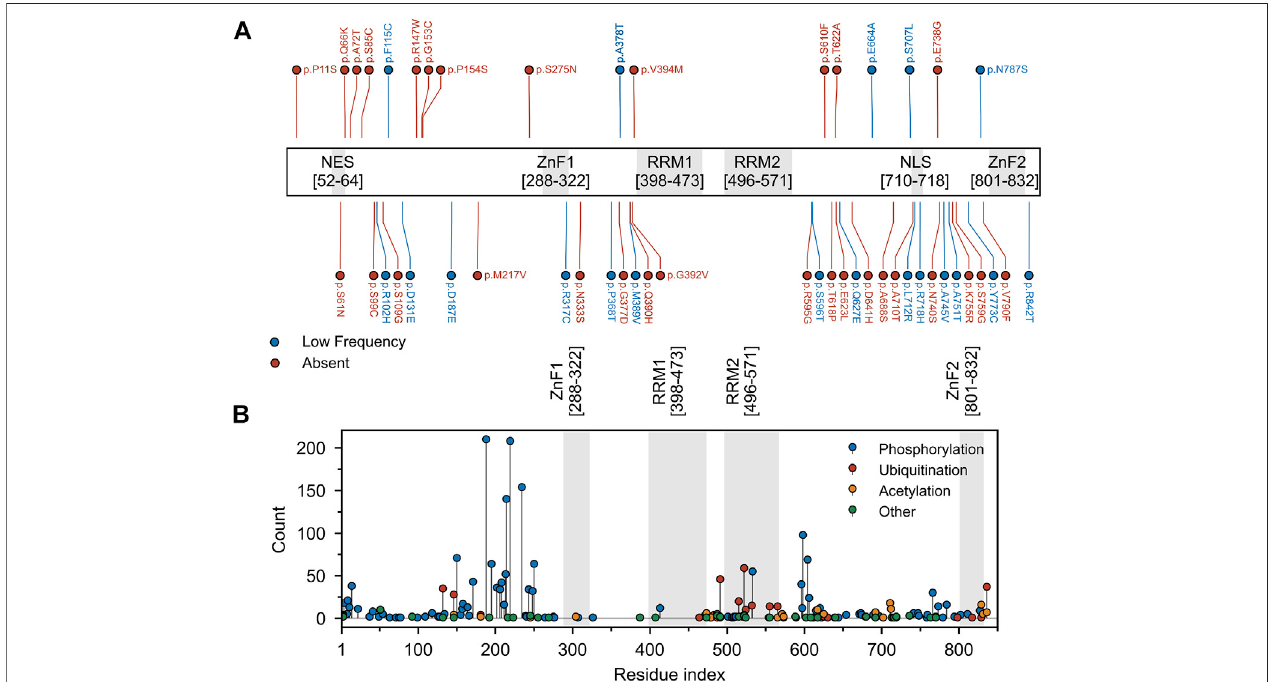
FIGURE6| Mutationand post-translational modi fi cations ofMatrin3. (A) Variant datawasplotted asafunctionofresidue index. Variants include thosereportedto be associated with ALS within the relevant literature and those identi fi ed in the ALS Knowledge Portal (Farhan et al., 2019) and/or Project MinE (Project MinE ALS Sequencing Consortium, 2018) ALS whole genomes. Variants observed in the ALS Knowledge Portal or Project MinE ALS whole genomes were only included if the variant had not been observed in the respective study ’ s control cohort. All previously reported variants were missense variants. Red and blue points